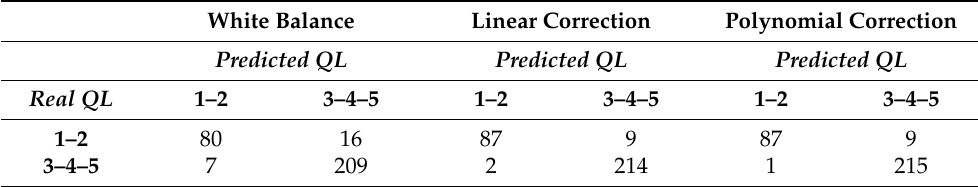
Table 5. Confusion Matrices obtained by the classification working on the datasets coming from the three different color correction models and with the task of separating marketable product (QL 5–4–3) from non-marketable product (QL 2–1).